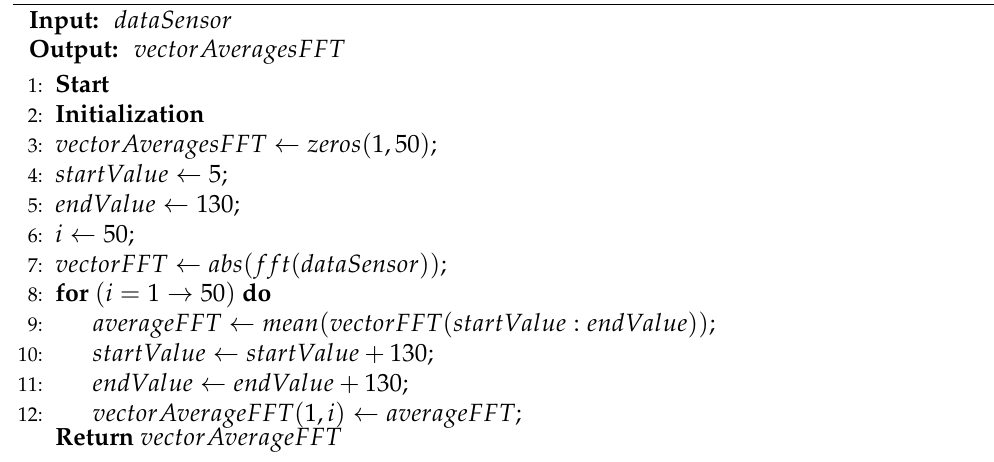
Algorithm 1 Average of sequences of the signal